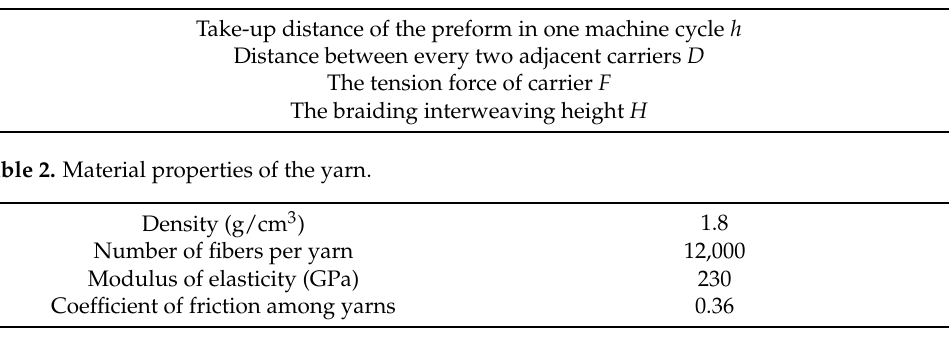
Table 1. The main process parameters of the 3D4D braiding process.